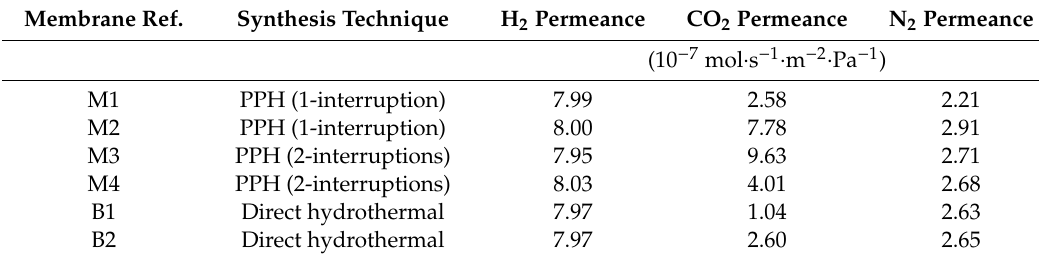
Table 1. Single gas permeation results of the as-synthesized membranes at 25 ◦ C and 0.18 MPa. PPH: Pore-Plugging Hydrothermal. Membrane Ref.